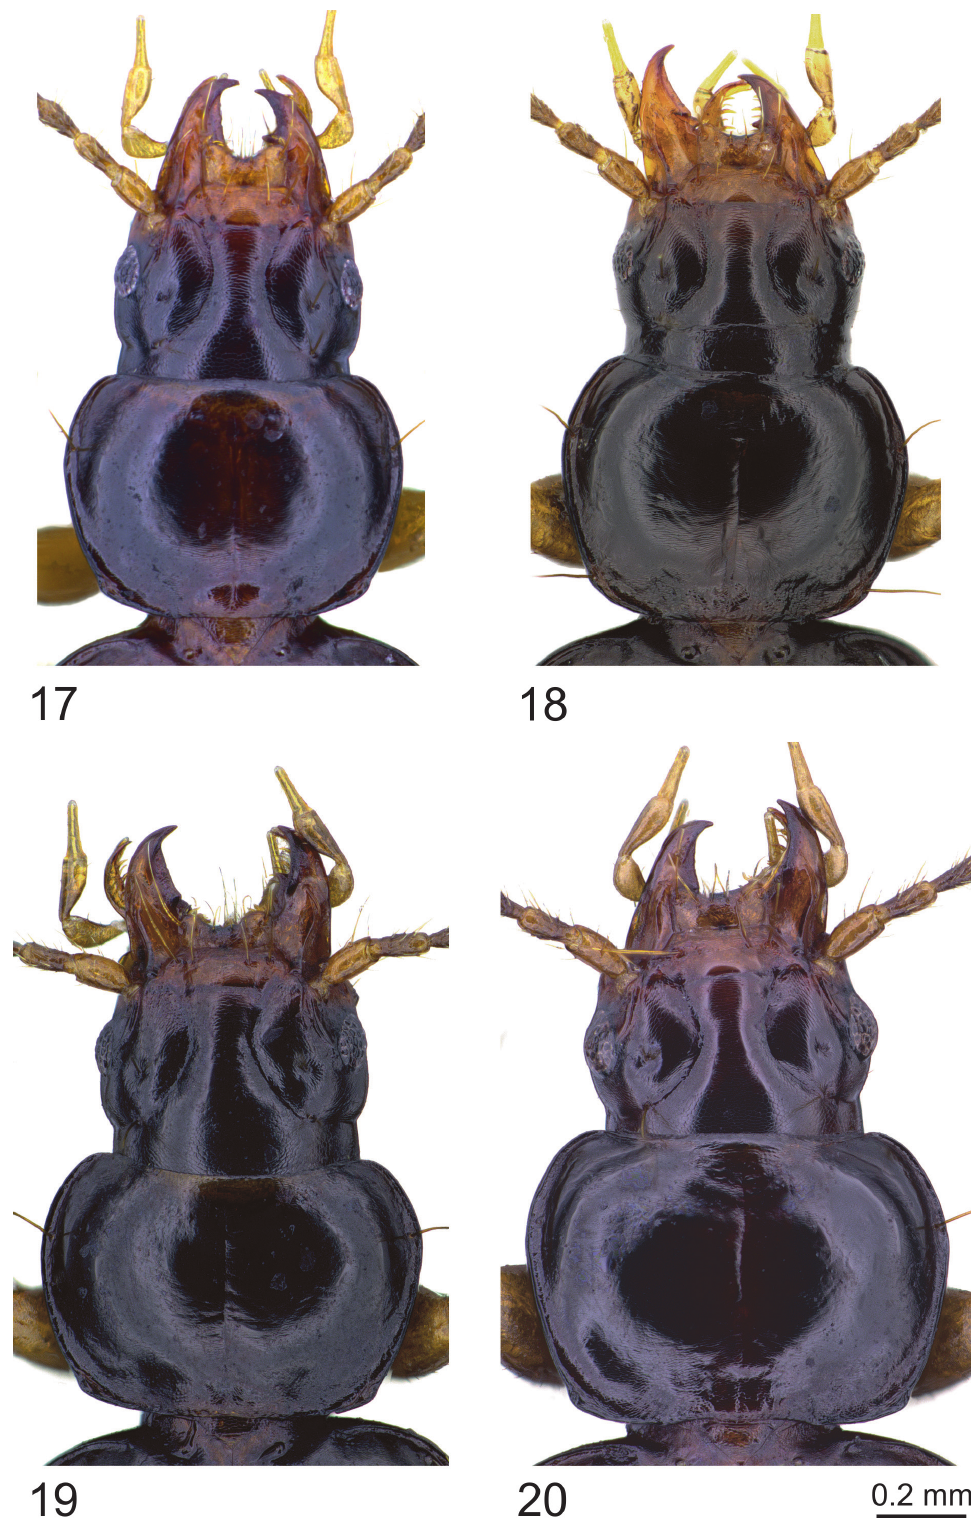
Figs 17–20. Trechus spp., head, pronotum. 17 . T. rira sp. nov., holotype. 18 . T. iridescens sp. nov., holotype. 19 . T. oppositus sp. nov., paratype, ♂. 20 . T. bombi sp. nov.,